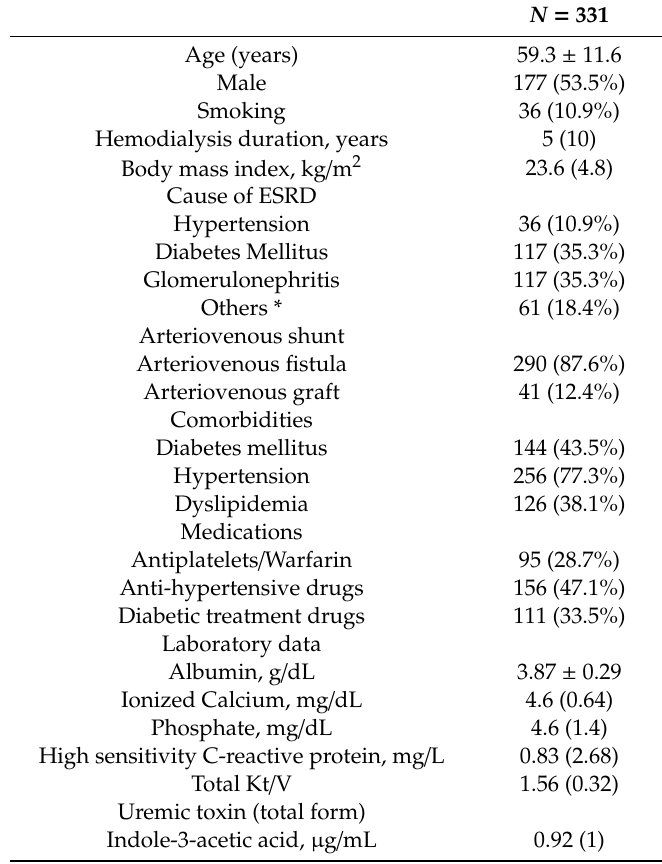
Table 1. Baseline characteristics of 331 hemodialysis participants.